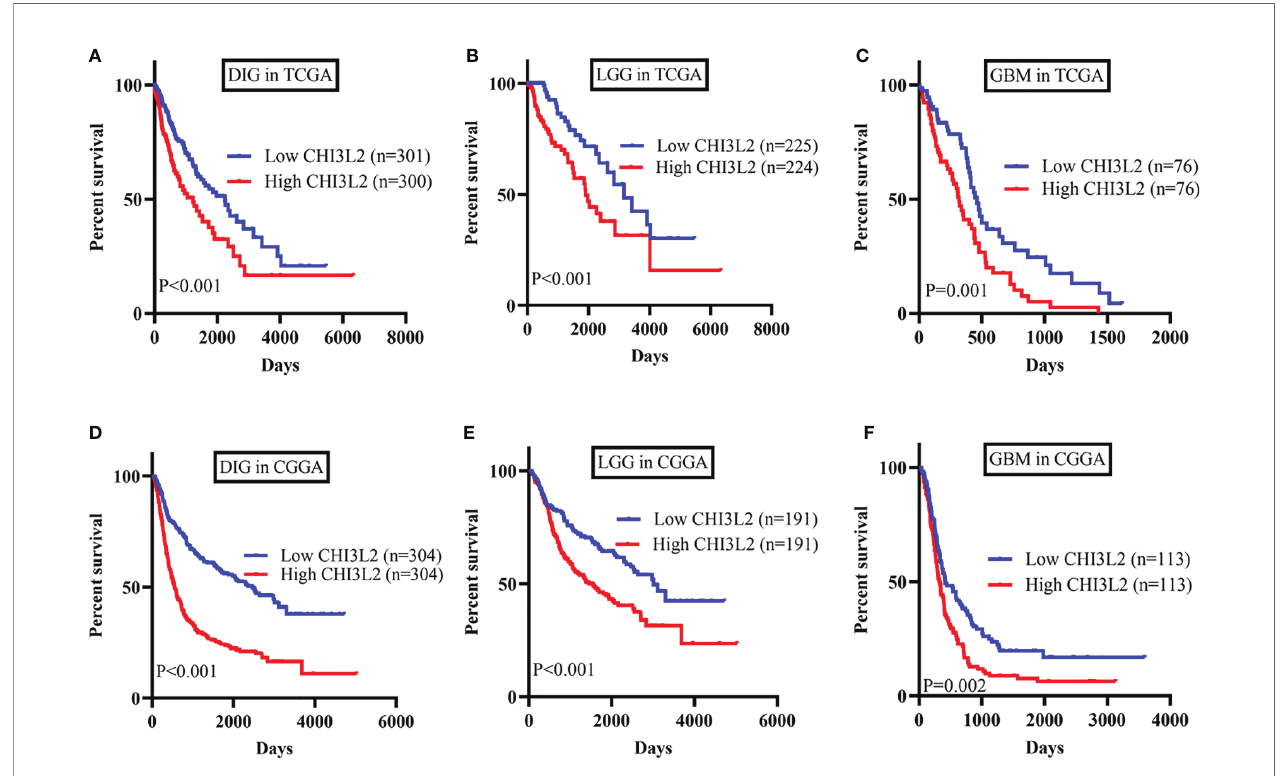
FIGURE 5 | The prognostic impact of CHI3L2 mRNA levels in gliomas in TCGA and CGGA datasets. Kaplan-Meier curves reveal high CHI3L2 mRNA levels predict short overall survival time in diffusely in fi ltrating glioma (DIG), LGG, and GBM in the TCGA dataset (A – C) and CGGA dataset (D – F)